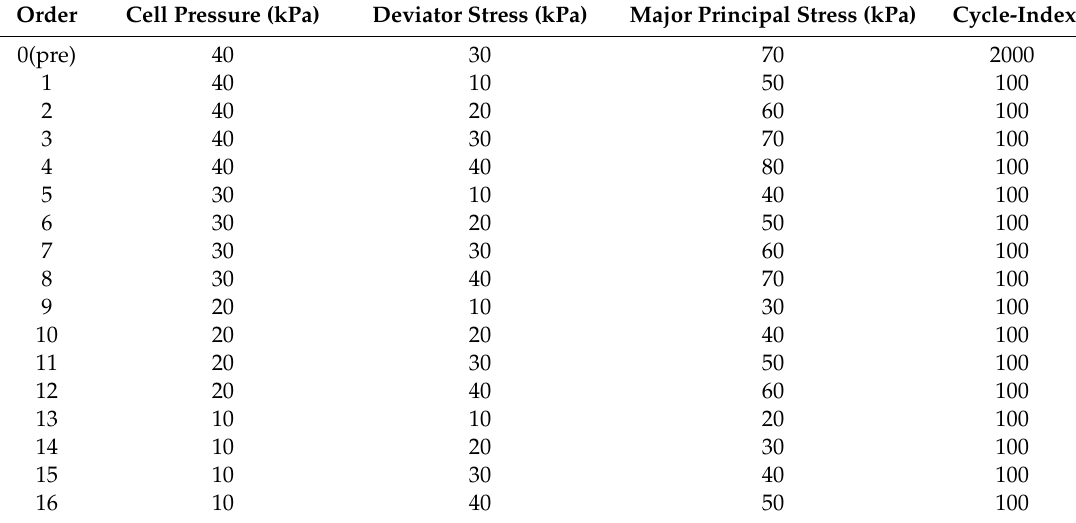
Table 3. Triaxial testing sequence for the soil-rock